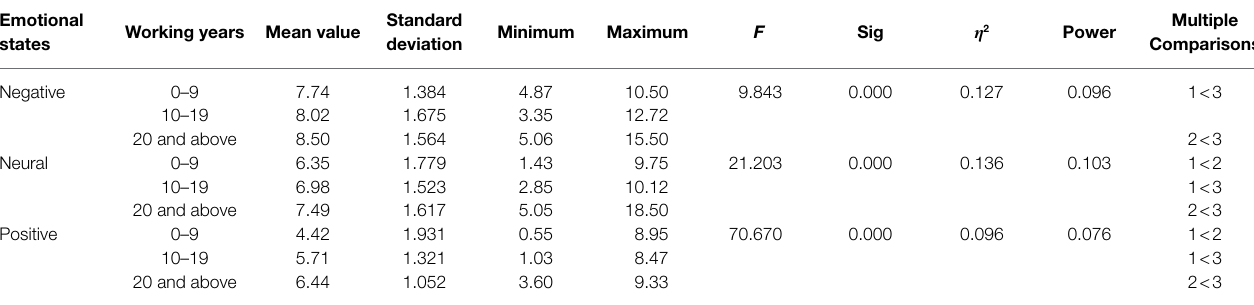
TABLE 8 | One-way ANOVA results for reaction time at different working ages. Emotional Working years Mean value states